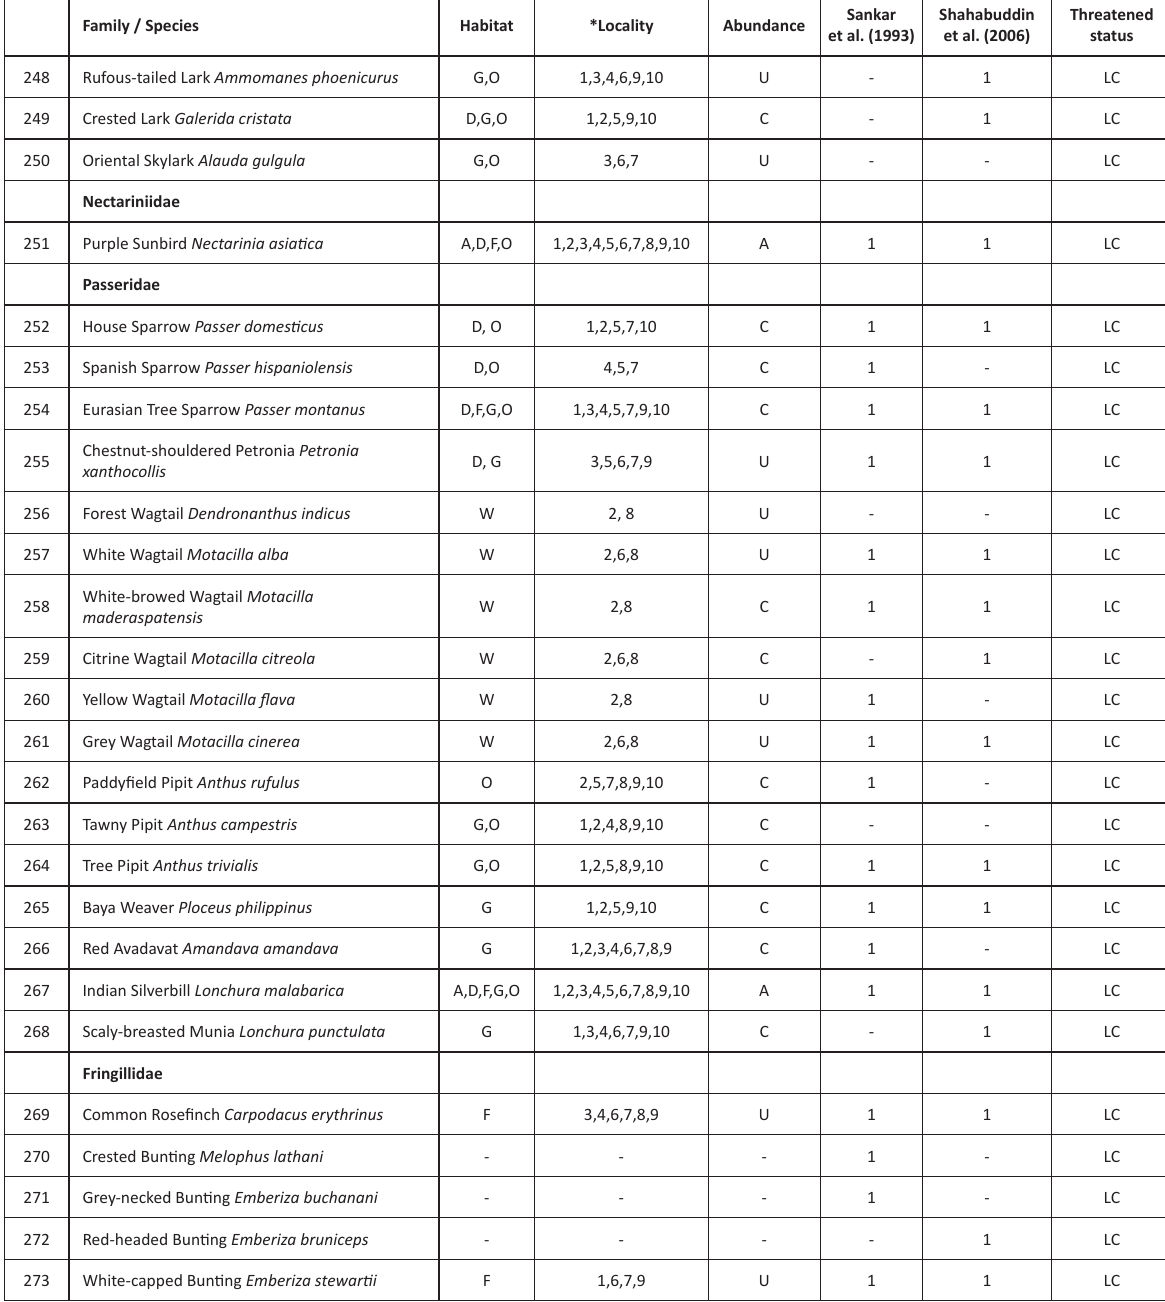
- - 1 - LC 272 Red-headed Bunting Emberiza bruniceps - - - - 1 LC 273 White-capped Bunting Emberiza stewartii F 1,6,7,9 U 1 1